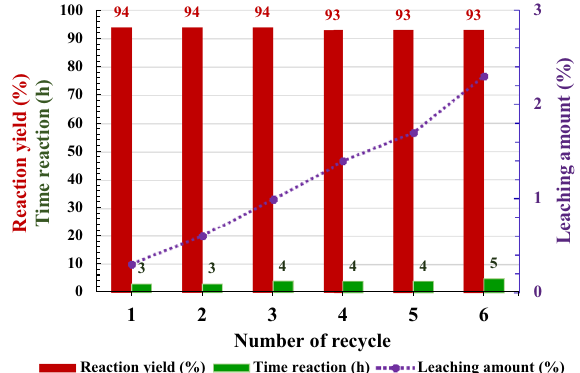
Figure 17. Determination, amount metal leaching of the Cu catalyst during 6th runs of the model reaction, in optimal reaction conditions; reaction conditions: iodobenzene (1.00 mmol), phenylacetylene (1.5 mmol), NaOH (2.0 mmol), catalyst (0.006 g, 0.8 mol% of Cu), H 2 O (5.0 mL), 80 °C.